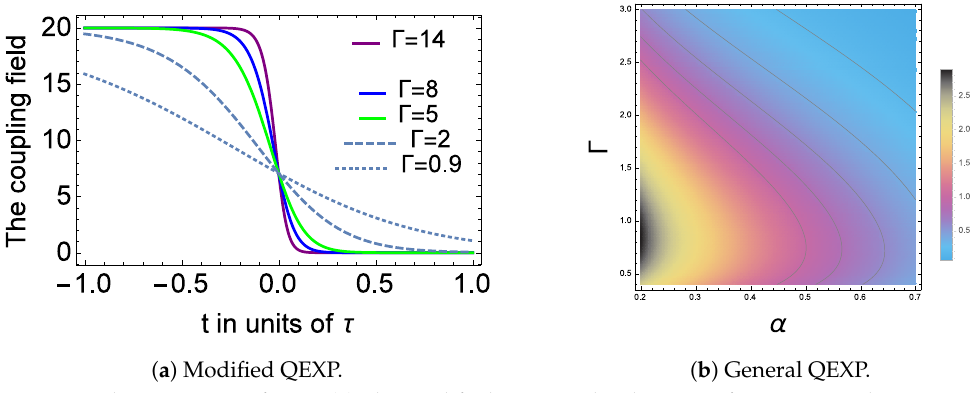
Figure 2. The QEXP waveforms: ( a ) The modified QEXP pulse dynamics for various pulse rise time factors Γ . ( b ) The Generalized QEXP pulse dynamics in terms of the shape factor α and the pulse rise time Γ